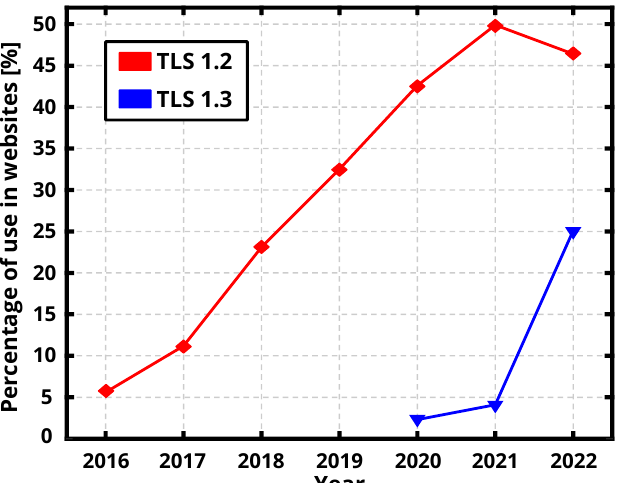
Figure 1. Percentage of use of Transport Layer Security version 1.2 and 1.3 in websites [32].